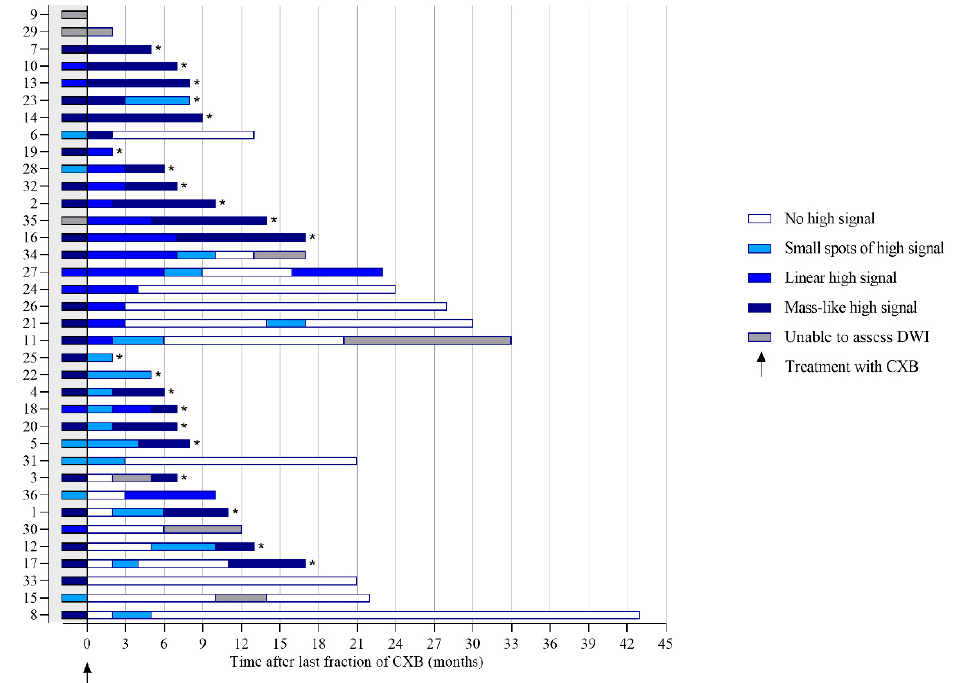
Figure 5. The morphology of the diffusion signal prior to and during follow-up after contact X-ray brachytherapy per patient. * Patients with histopathological confirmation of residual tumor.